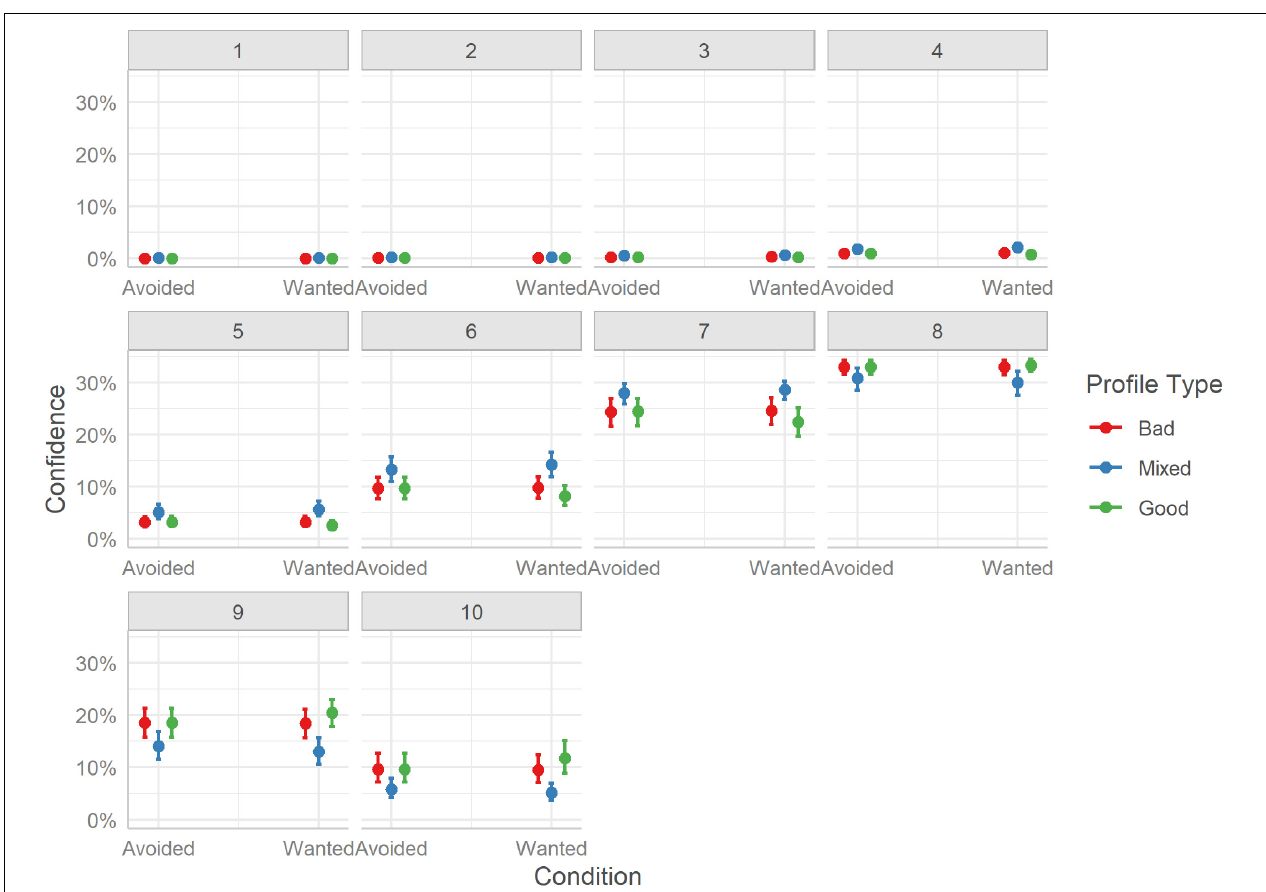
FIGURE 12 | Marginal effects of judgment confidence for profile classification. The posterior mean estimates of the probability of responses in each of the three Profiles (Bad, Good, Mixed) by the two experimental Conditions (Avoided or Wanted). Error bars indicate 95% credible intervals.